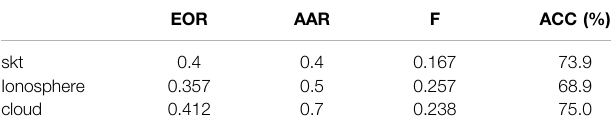
TABLE 4 | Comparison of performance of three